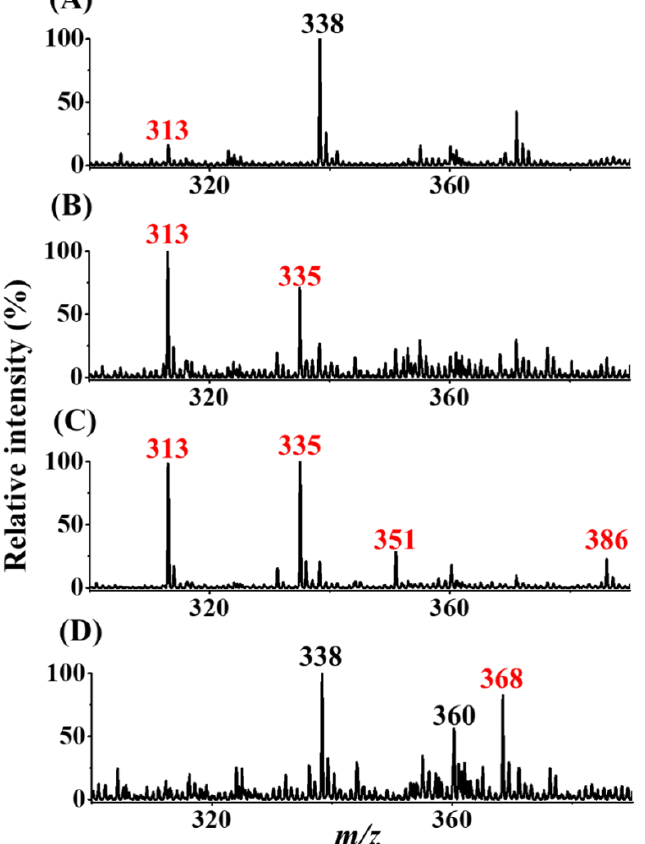
Figure 5. Mass spectra obtained without and with the addition of butylamine in the elution solvent for online SPME-CFI-MS analysis. ( A ) Direct CFI-MS mass spectrum of the sample (10 µ L) containing AFB1 (50 nM). SPME-CFI mass spectra of samples obtained from the SPME fiber adsorbed with AFB1 ( B ) without and ( C ) with the addition of butylamine (10 nM) in the elution solvent containing acetonitrile/ethanol/deionized water (2:2:1, v / v / v ). A 2B pencil lead was used as the SPME fiber to enrich AFB1 (50 nM) from the sample solution (7.5 mL) prepared in Tris buffer (pH 8) under stirring for 2 h. ( D ) SPME-CFI mass spectrum obtained from the sample (7.5 mL) containing AFB1 (~1.25 nM) in Tris buffer (pH 8) after enrichment using our